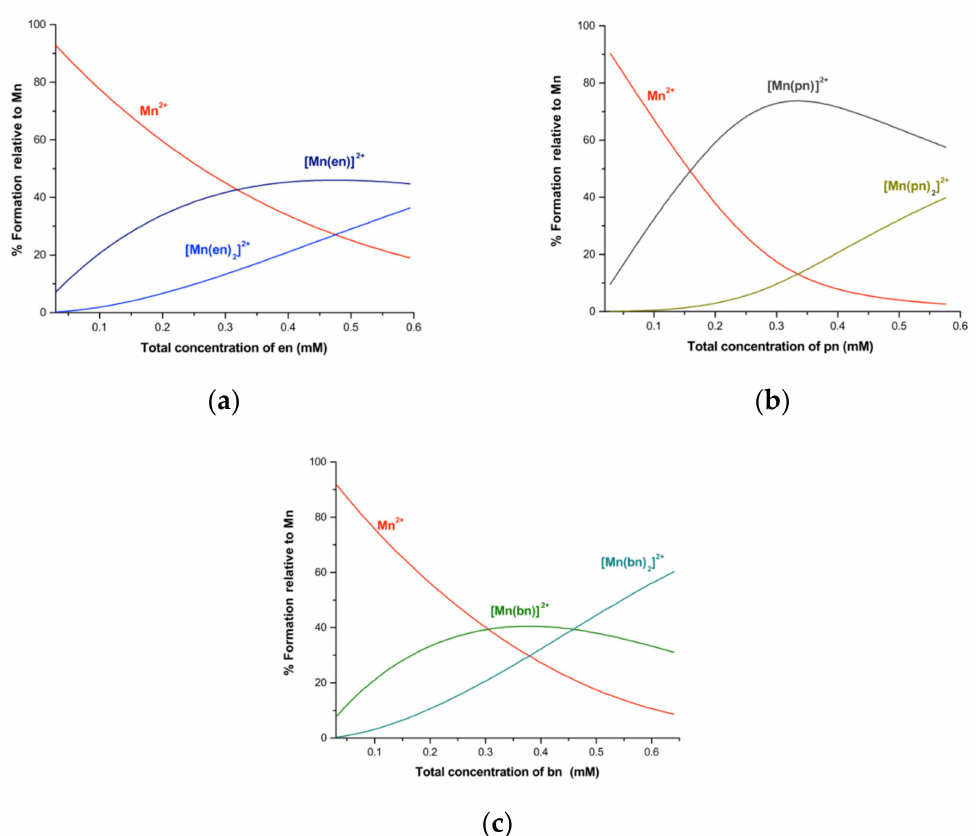
Figure 7. ( a ) Formation curves of the manganese(II)-ethylenediamine system in methanol. [Mn] 2+ = 0.3 mM and ethylenediamine range from 0.03 to 0.6 mM. ( b ) Formation curves of the manganese(II)-1,3-propanediamine system in methanol. [Mn] 2+ = 0.288 mM and 1,3-propanediamine range from 0.0288 to 0.576 mM. ( c ) Formation curves of the manganese(II)-1,4-butanediamine system in methanol. [Mn] 2+ = 0.16 mM y 1,4-butanediamine range from 0.032 to 0.64